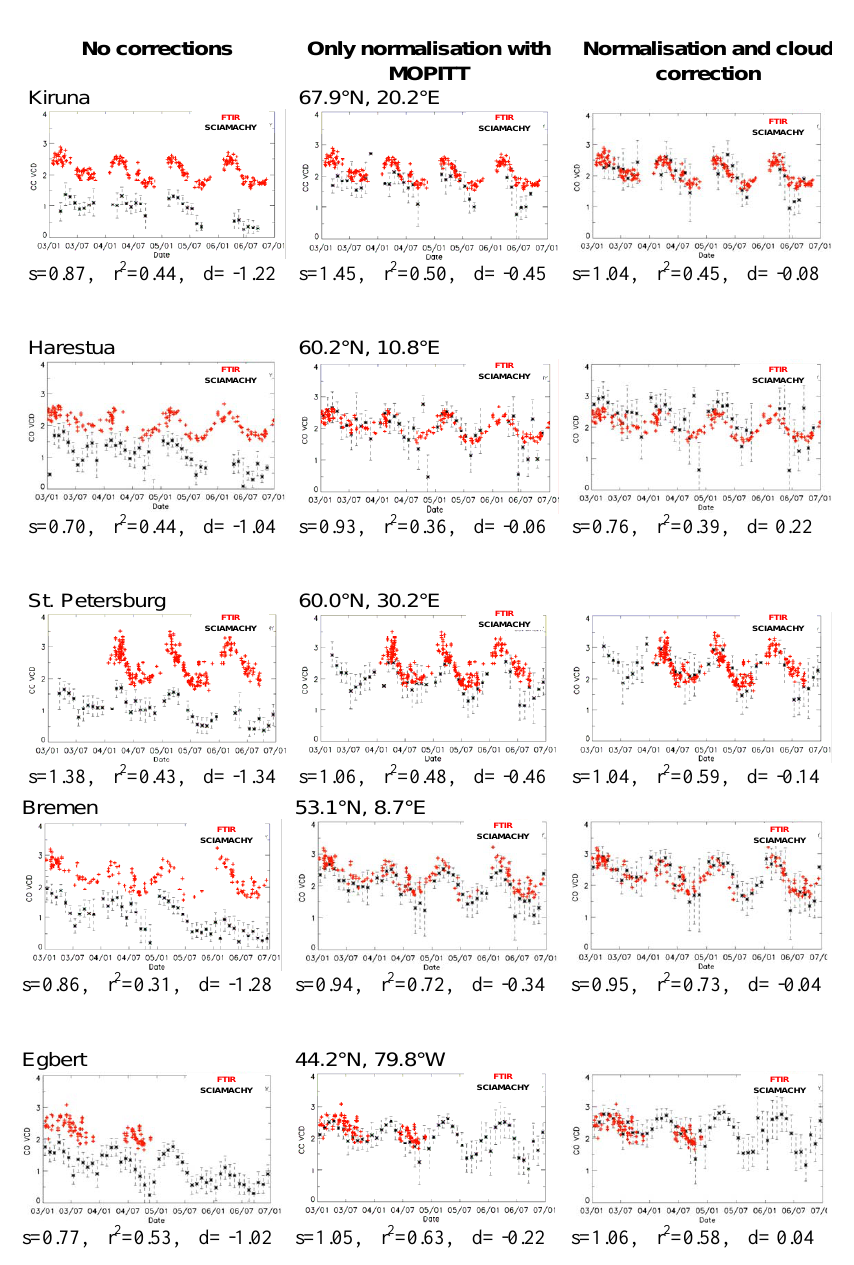
Fig. 7. Comparison of SCIAMACHY CO VCDs (black dots, monthly means) with coincident results from ground based FTIR stations. In the left part of the figure, uncorrected CO VCDs are shown; in the center part the same data are shown after normalisation with MOPITT observations (see Sect. 3); in the right part of the figure, also a cloud correction was applied (see Sect. 4). The numbers below the figures indicate the results of the correlation analyses (s: slope, r 2 : coefficient of determination) and the average difference between both data sets (d: SCIAMACHY CO VCD – FTIR CO VCD in units of 10 18 moleccm − 2 ) .